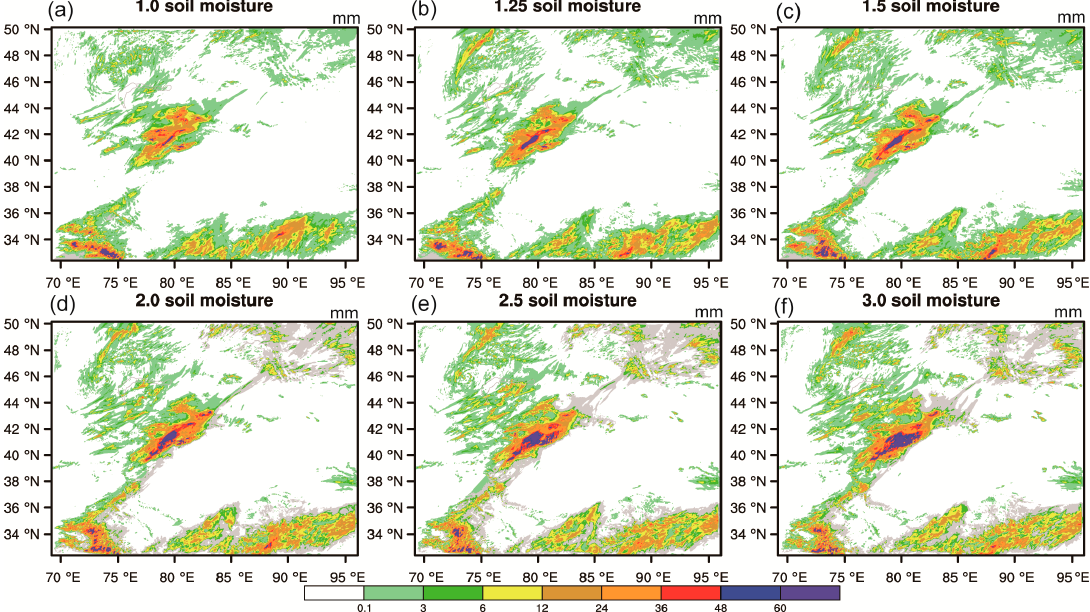
Figure 9. The 24-h accumulative precipitation at 002 UTC 17 August 2019 of the WRF simulations under different soil moisture initial conditions. Note that ( a ) 1.0; (b) 1.25; ( c ) 1.5; ( d ) 2.0; ( e ) 2.5; and ( f ) 3.0 multiples of NCEP GFS soil moisture are denoted as ( a ) “1.0 soil moisture”; ( b ) “1.25 soil moisture”; ( c ) “1.5 soil moisture”; ( d ) “2.0 soil moisture”; ( e ) “2.5 soil moisture”; and ( f ) “3.0 soil moisture”, respectively. Precipitation is measured in millimeters.